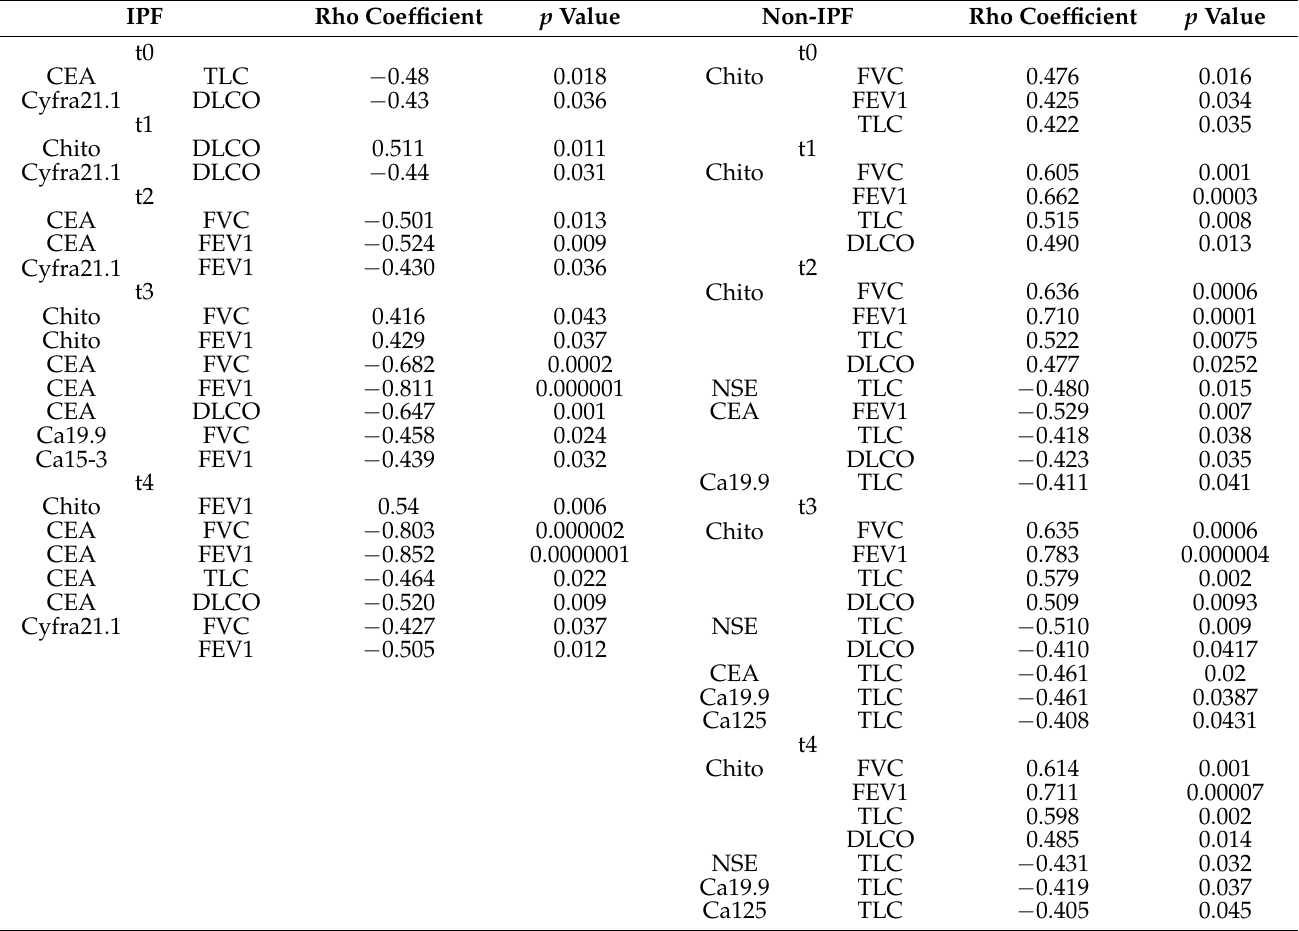
serum concentrations of CEA and FEV1, FVC and DLCO percentages at t3 and t4. Table 3. Correlation analysis between serum biomarkers and pulmonary function test (PFT) parameters in the two subgroups. Abbreviations: FVC, forced vital capacity; FEV1, forced expiratory volume in 1 second; DLCO, diffusing lung for carbon monoxide; CEA, carcinoembryonic antigen; TLC, total ling capacity.